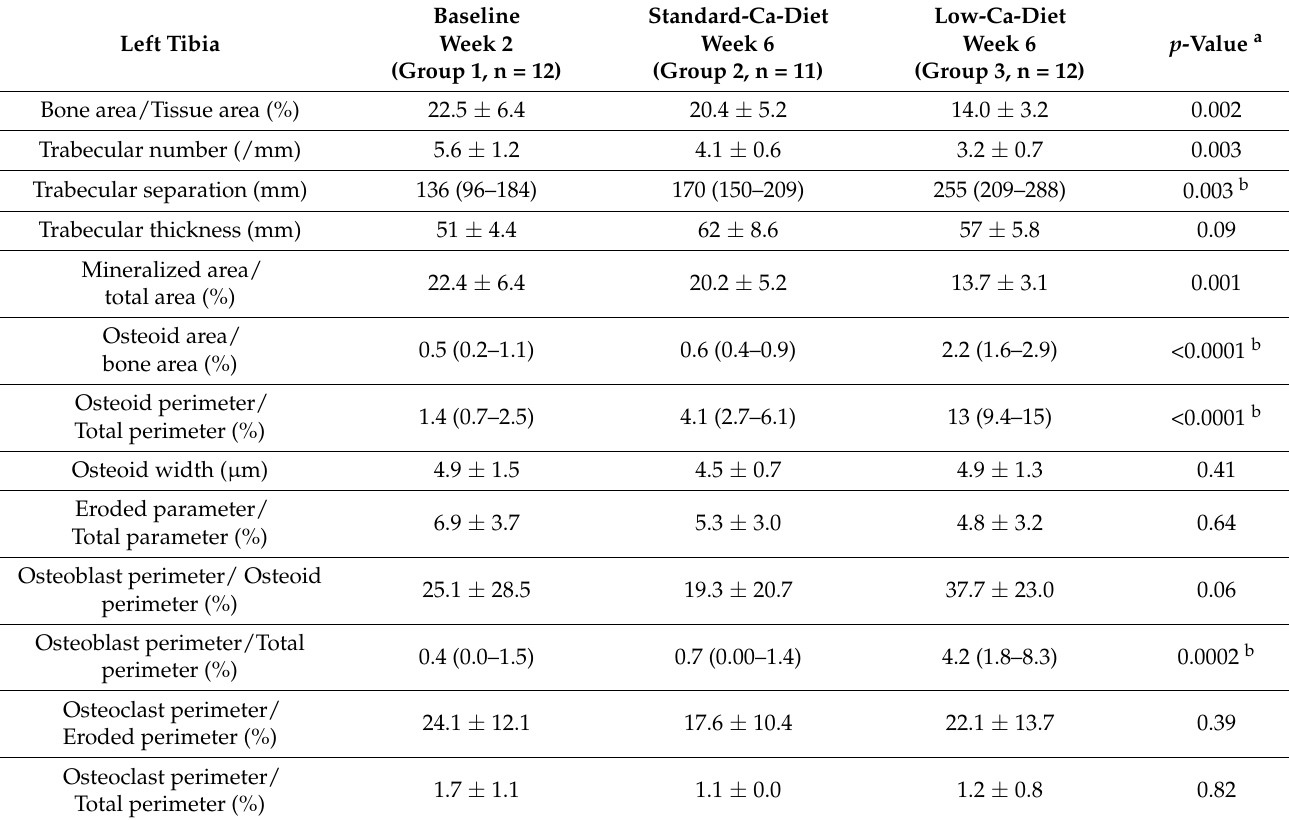
Table 3. Tibia histomorphometry after two weeks on standard-diet (group 1, 0.5% Ca) and a subse- quent four weeks of standard-diet (group 2, 0.5% Ca) and low-Ca-diet (group 3, 0.25% Ca). Bone analysis was performed in the proximal metaphysis and